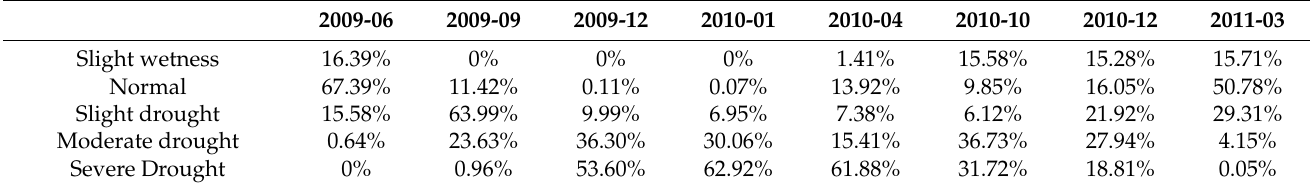
Table 2. Percentage of drought extent in 2009–2010 (according to sc_PDSI classification criteria).